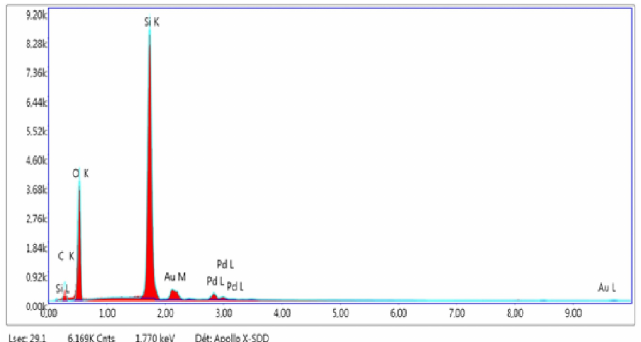
Figure 1. EDS spectra of the SiO 2 particles showing the composition (purity) of the sample.